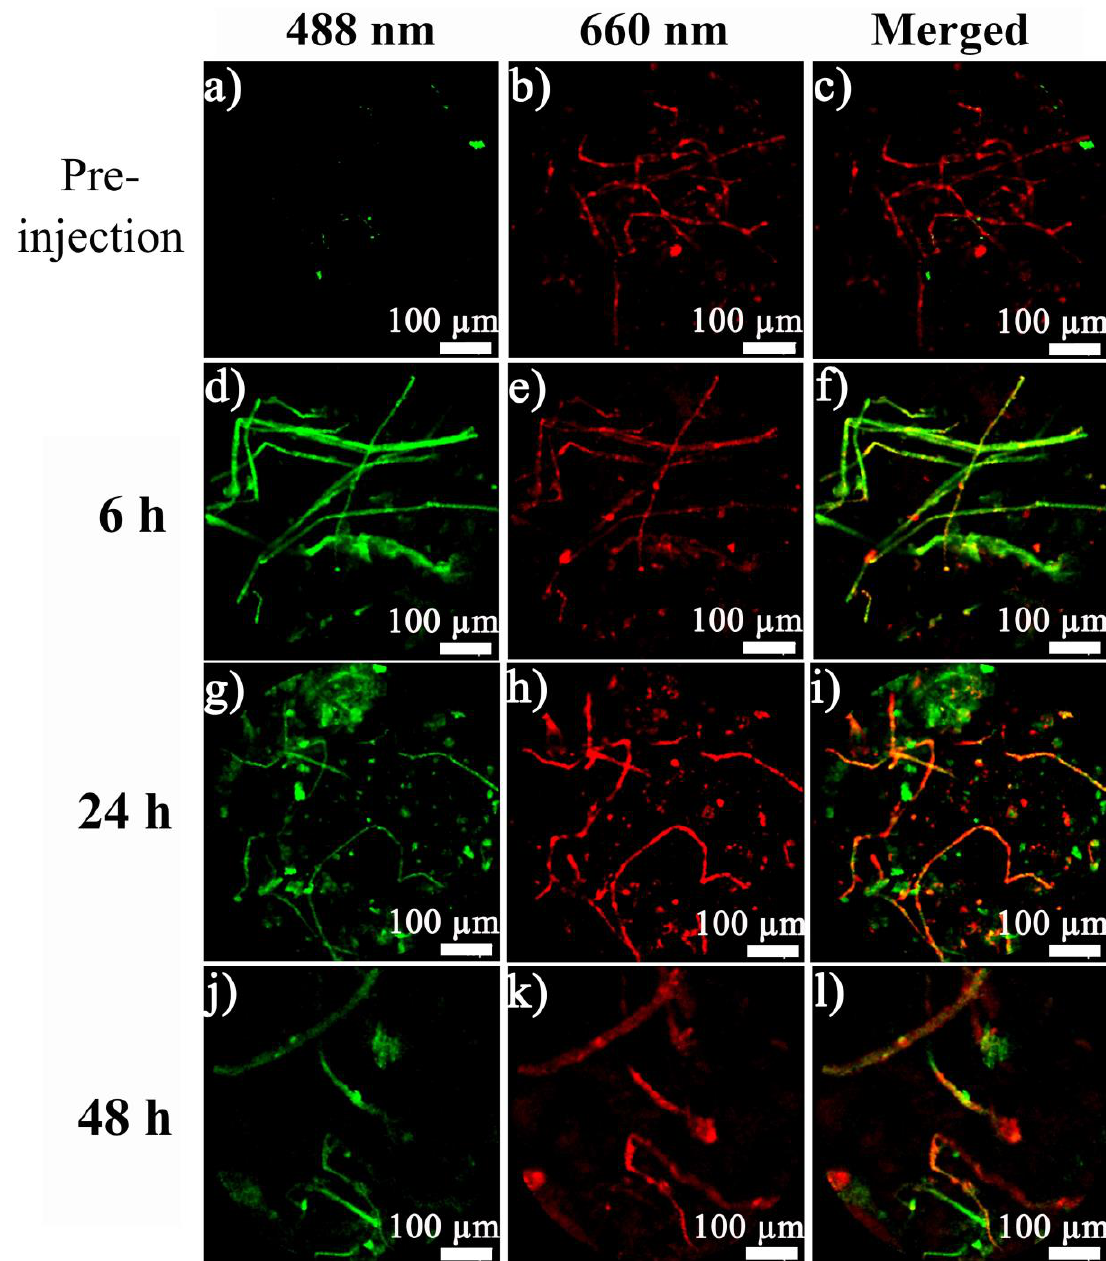
Figure 4. Fibered confocal fluorescence microscopic (FCFM) images of GQD-NPs (imaged under 488 nm excitation, green) and blood vessels (imaged by tail vein injection of Evans blue under 660 nm excitation, red) in tumor tissues over time.